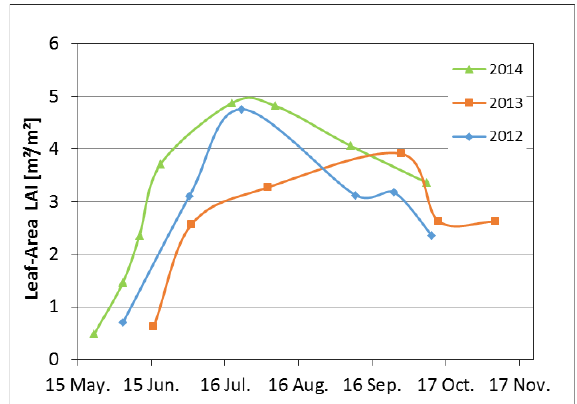
Figure 7: Development of LAI in the years 2012 to 2014